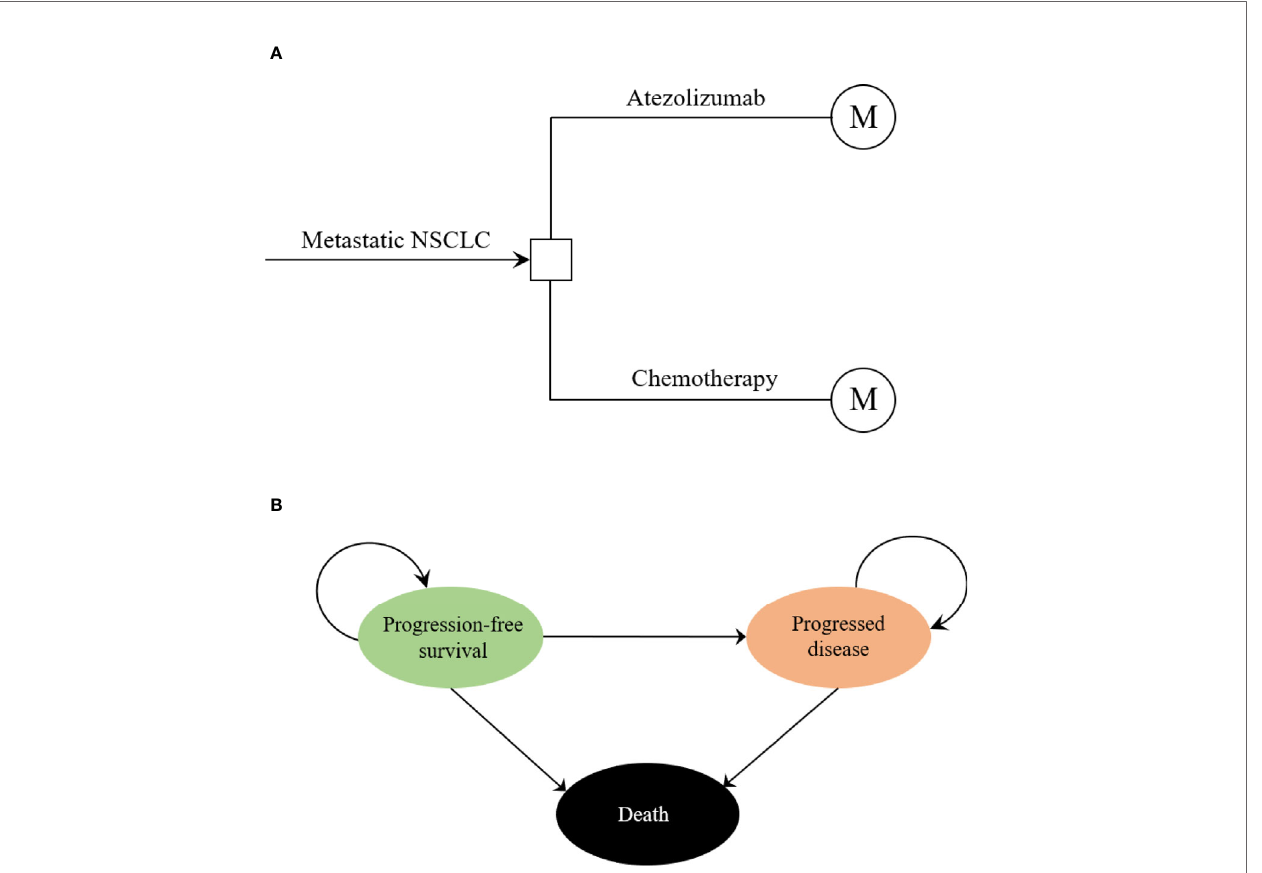
FIGURE 1 | The structure of the (A) decision tree and (B) Markov model. NSCLC, non-small-cell lung